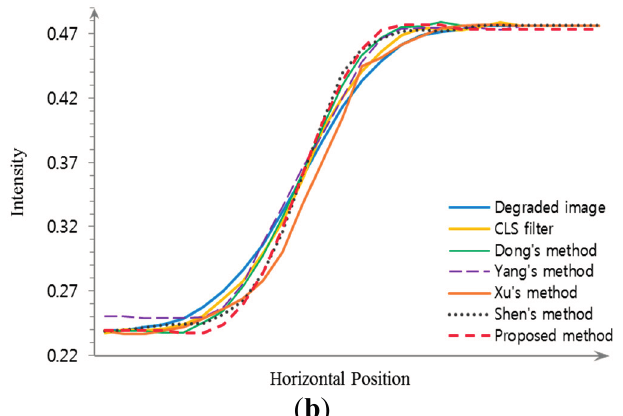
Figure 10. Comparison of different restoration algorithms using the ideal step function; ( a ) the step responses of edge around the rectangle in Figure 9b; ( b ) the step responses of edge around the triangle in Figure 9b.